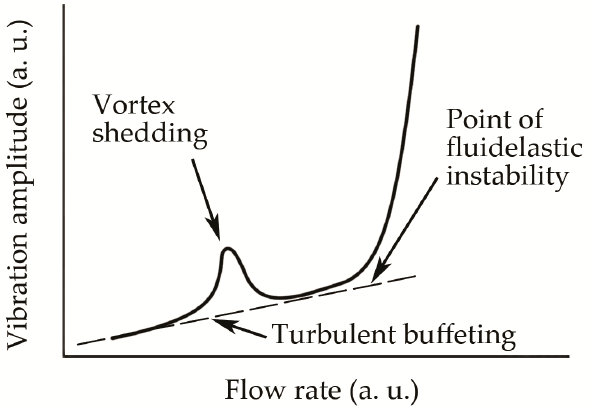
Figure 3. Relationship between vibration amplitude and flow rate.